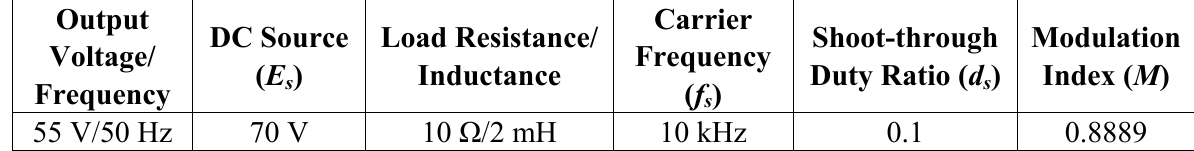
Table 1. Parameters of designed single-phase ZSI.